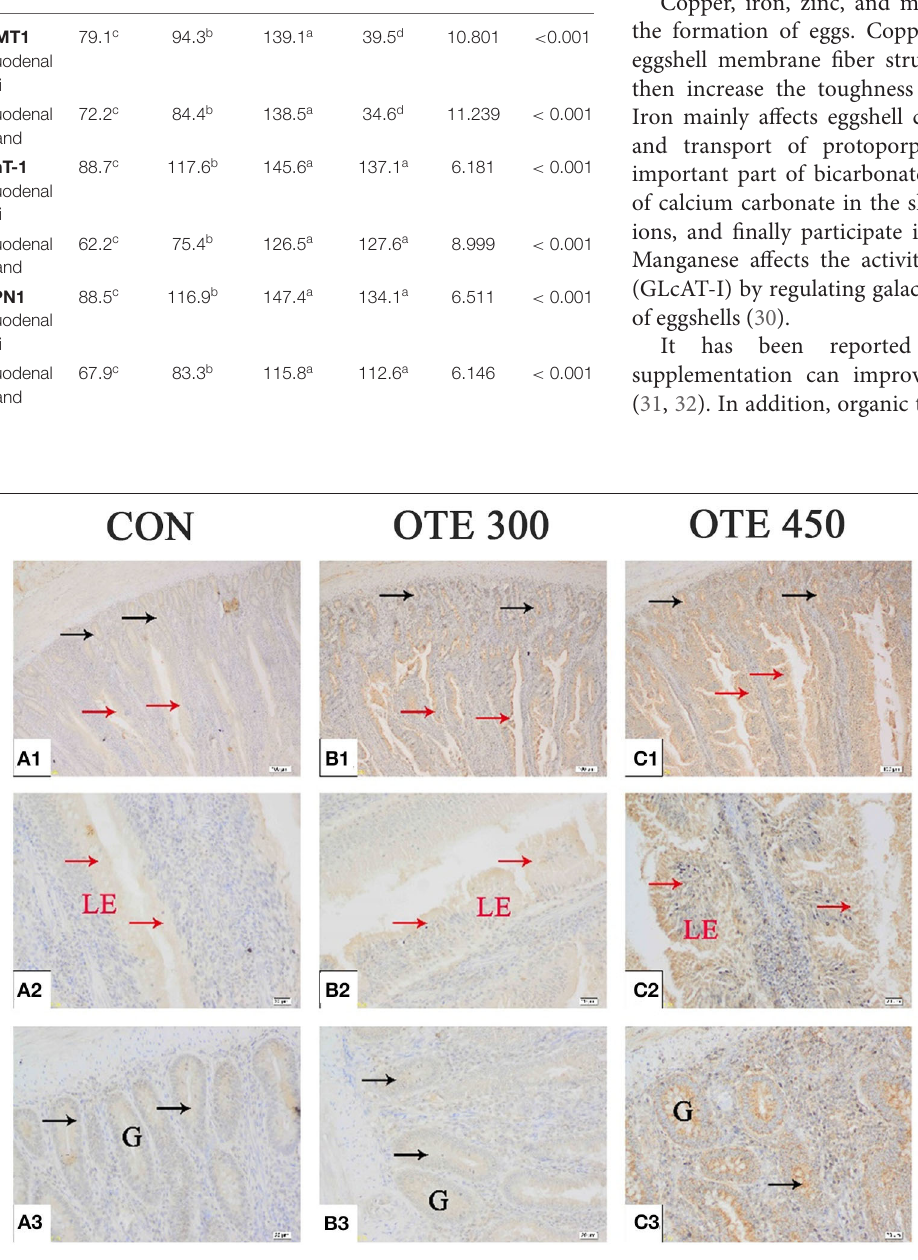
FIGURE 2 | Effects of organic trace elements supplementation on divalent metal transporter (DMT1) localization in duodenum of late-phase laying hens. (A–D) Represent the control, 300, 450, and 600 mg/kg organic trace elements groups, respectively. Scale bars were 100 µ m (A1–D1) and 20 µ m (A2–D2,A3–D3) . The red arrow represents DMT1 immunopositive cells in the duodenal villi, and the black arrow represents DMT1 immunopositive cells in the duodenal gland ( n = 6).